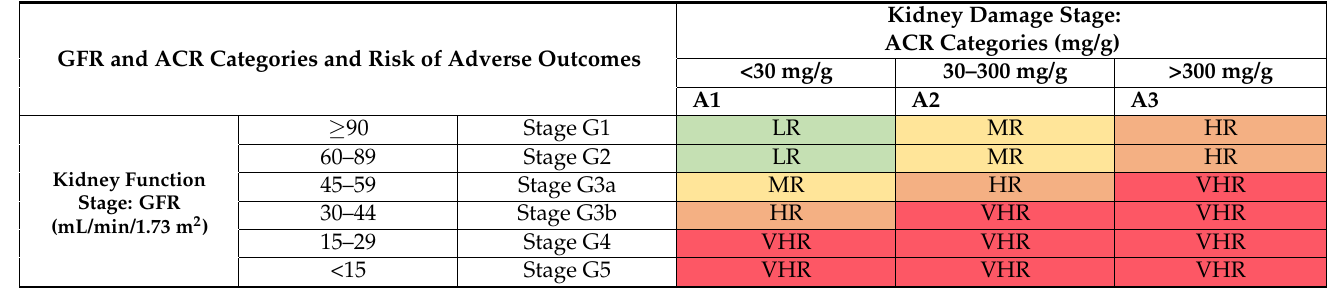
Table 1. Classification of CKD using GFR and ACR